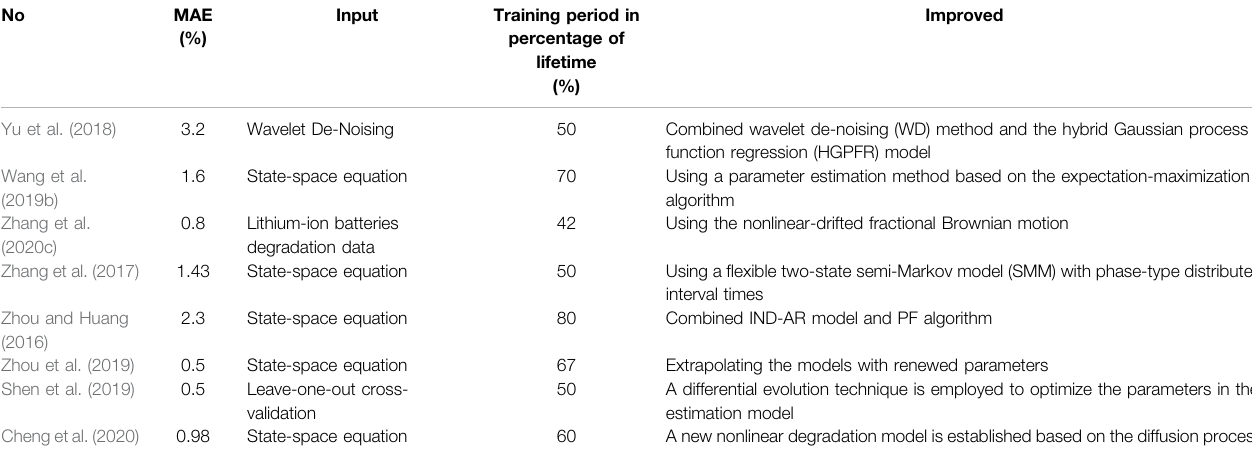
TABLE 3 | The comparison of stochastic process methods